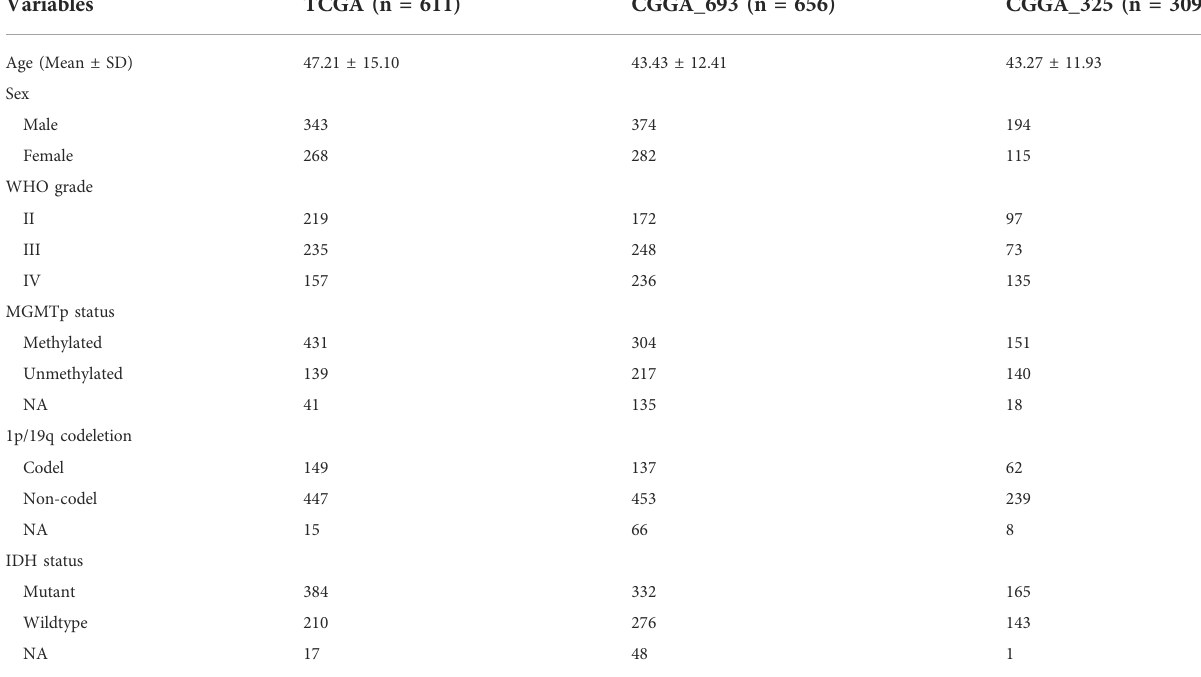
TABLE 1 Clinicopathological features of the patients in the TCGA, CGGA_693, and CGGA_325